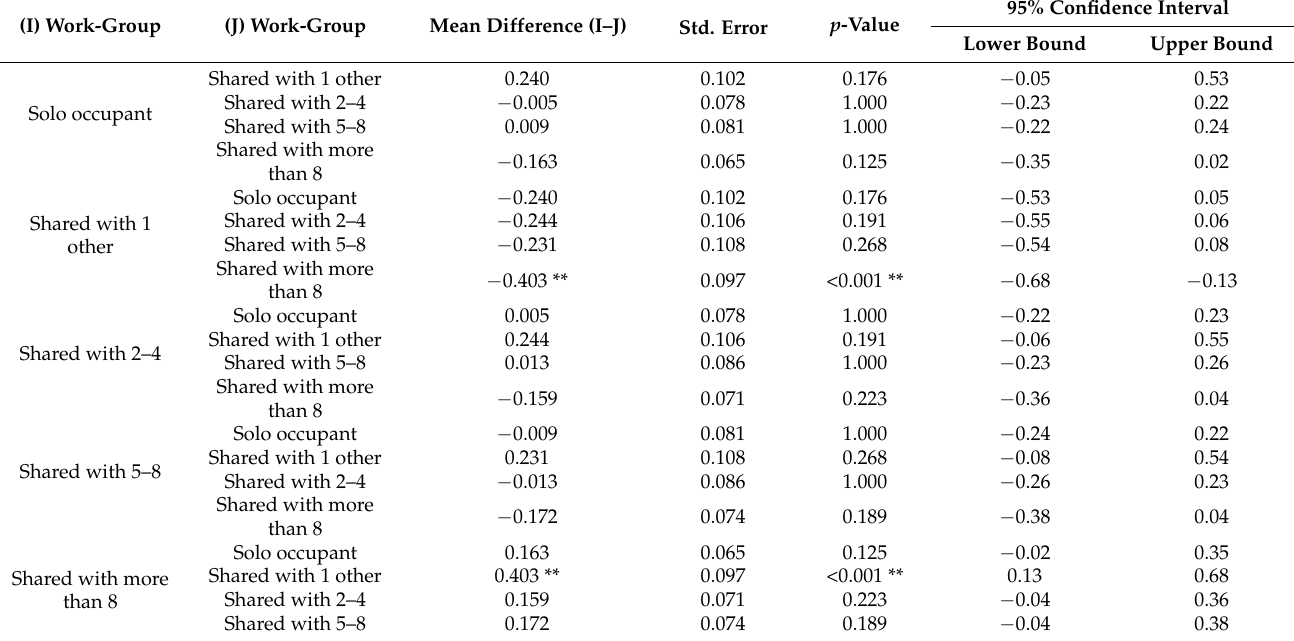
Table 19. Multiple comparisons and Tukey HSD analysis for unwanted interruptions among different